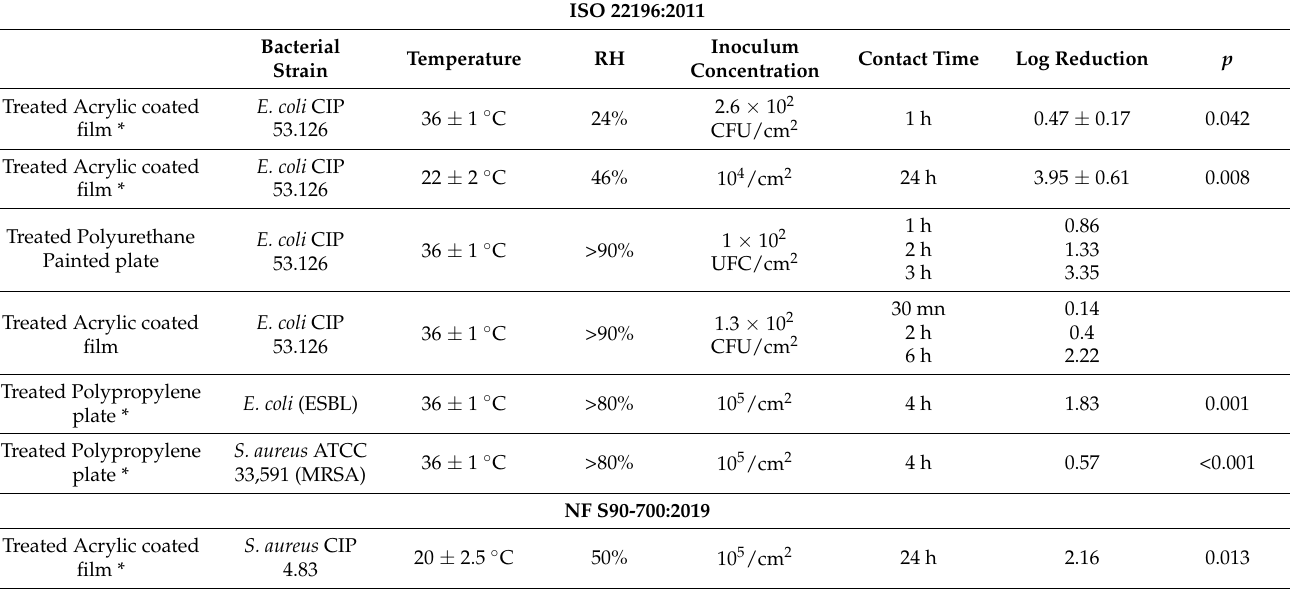
Table 5. Log reductions per cm 2 after varying the testing conditions (temperature, RH, contact time, and inoculum size) for different types of nonporous